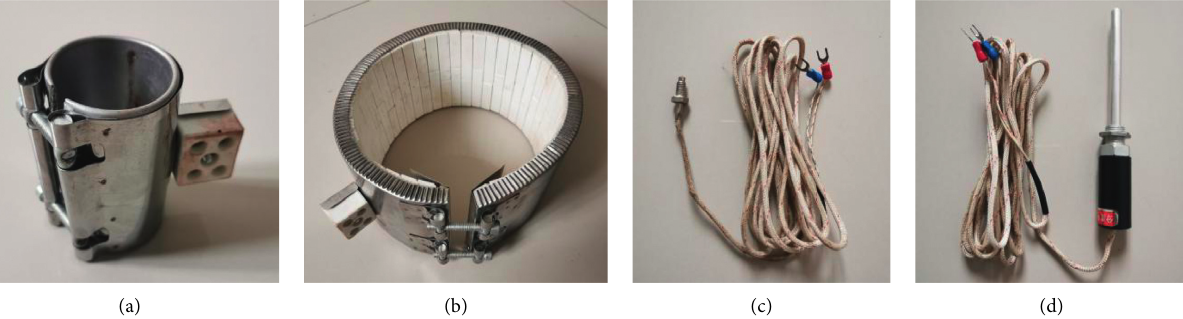
Figure 5: Heating ring and temperature sensor of drawing specimen: (a) a stainless-steel heating ring; (b) a ceramic heating ring; (c) screw type sensor; (d) K-type temperature